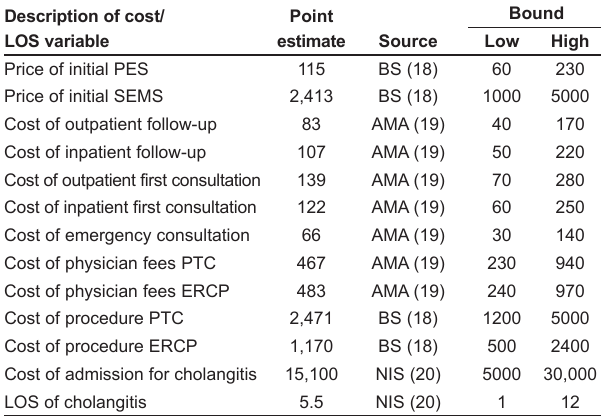
TAble 3 Cost and length of stay (lOS) estimates of the